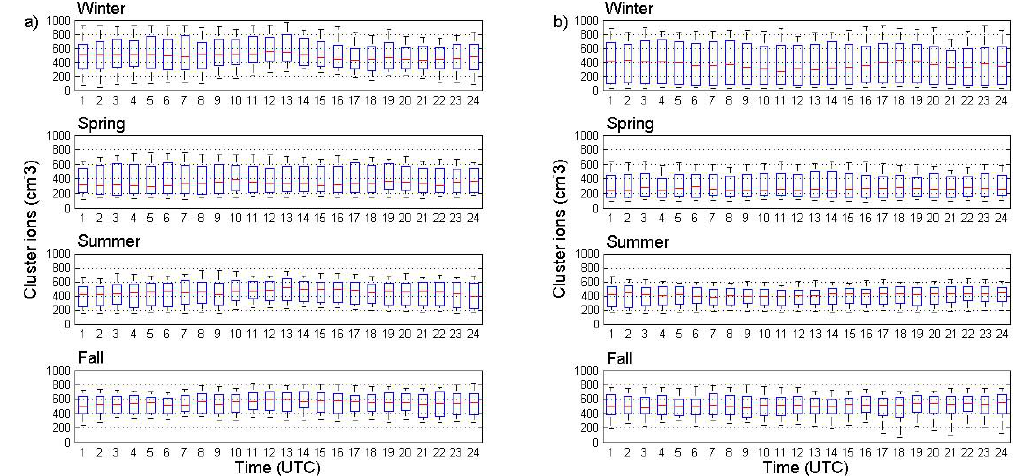
Fig. 3. Diurnal variation of positive cluster ion (0.8–1.9nm) concentration on (a) event days and (b) non-event days. Red line represents the median value, bottom and top sides of the blue boxes symbolize the 25th and 75th percentile, respectively, and the extremities of the black lines stand for the 10th and 90th percentile. February 2007–February 2012, Puy de Dôme.